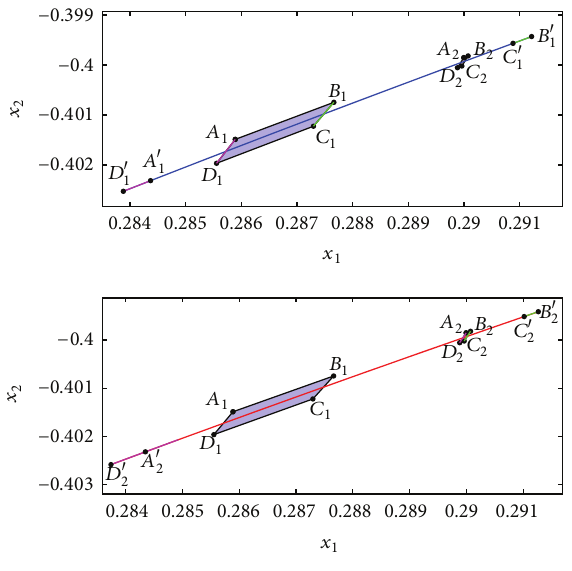
Figure 9: The new topological